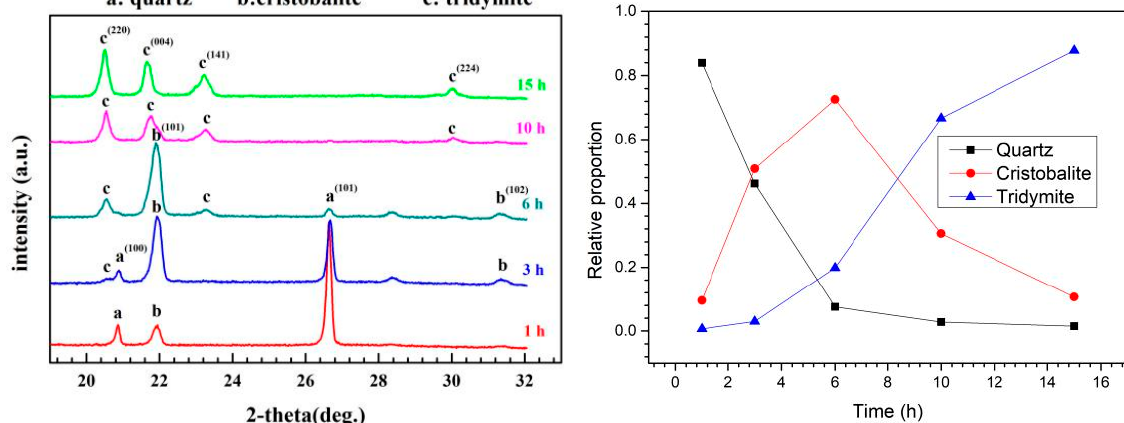
Figure 10. Phase evolution of fine quartz—potassium silicate glass composites after holding at 1000 °C for different time.